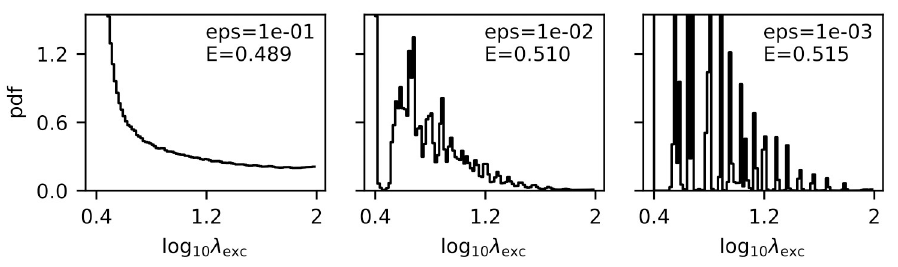
Fig 7. Approximately optimal input probability distributions. The plots show different input probability distributions obtained from different steps of the Jimbo-Kunisawa algorithm. For each input distribution the estimated efficiency E (in bits / 10 9 ATP) is given in the plot together with the relative error eps (to the true value of the efficiency). The true value of the efficiency (Eq (18)) can be nearly reached with very different input probability